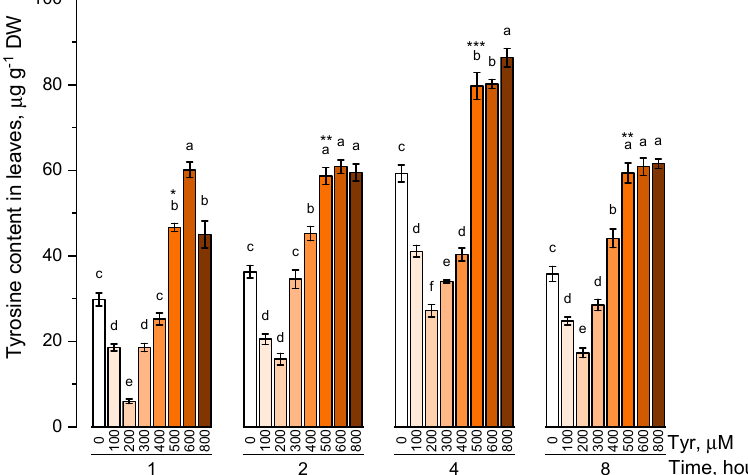
Figure 2. Intracellular content of free tyrosine in common wheat incubated on tyrosine-enriched medium containing various concentrations of the amino acid (100, 200, 300, 400, 500, 600, and 800 μ M) for 1, 2, 4, 8 h. Bars marked with different letters show significant differences for the defined time of cultivation with tyrosine; asterisk * indicates significant differences among plants exposed for a different time at 500 μ M ( p ≤ 0.05, Tukey’s test).